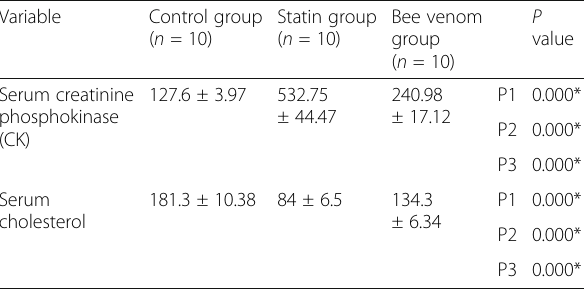
Table 3 Serum creatinine phosphokinase and serum cholesterol in the studied